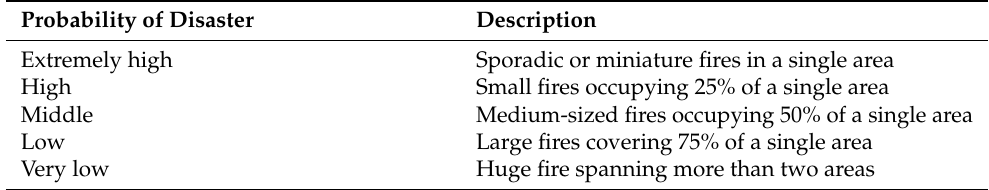
Table 2. Explanation table of the probability of fire disaster.